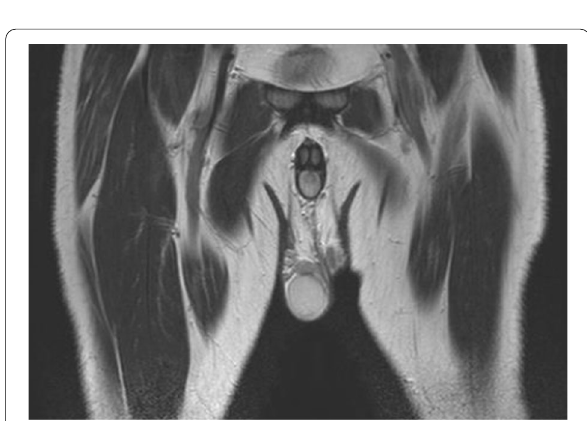
Fig. 3 MRI coronal T2 weighted image shows right normal testis and small soft tissue nodule noted in the region of left testis and at the tip of left spermatic cord